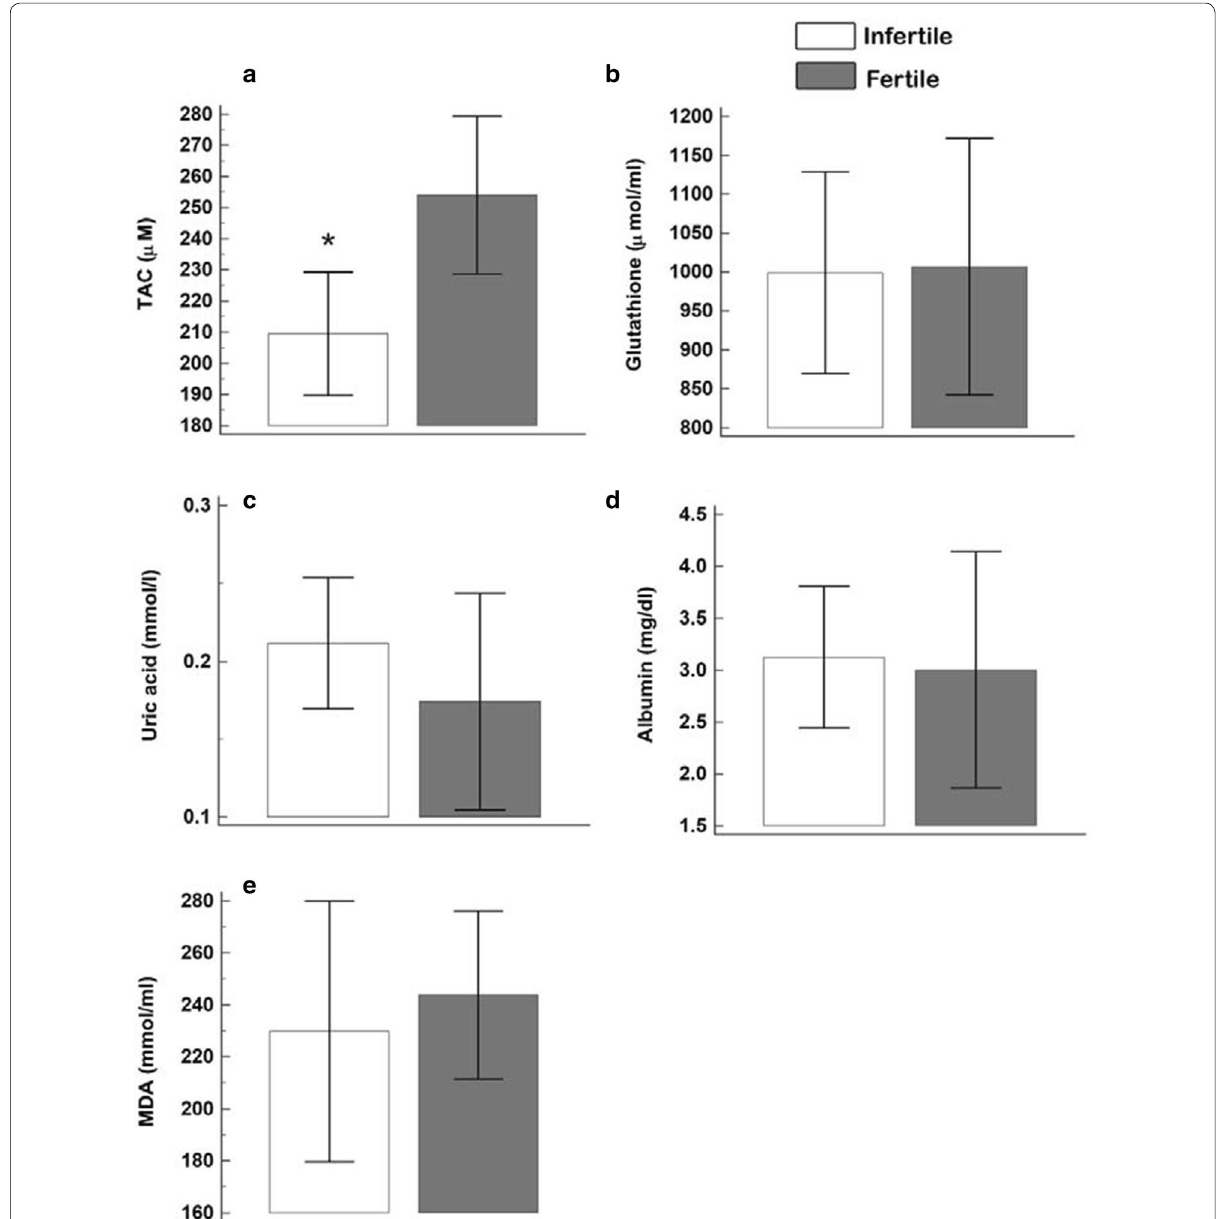
Fig. 2 Serum oxidative stress markers of Idiopathic infertile and fertile men in seminal plasma a TAC, b glutathione, c uric acid, d total protein and e MDA. *Significant ( p < 0.01) versus